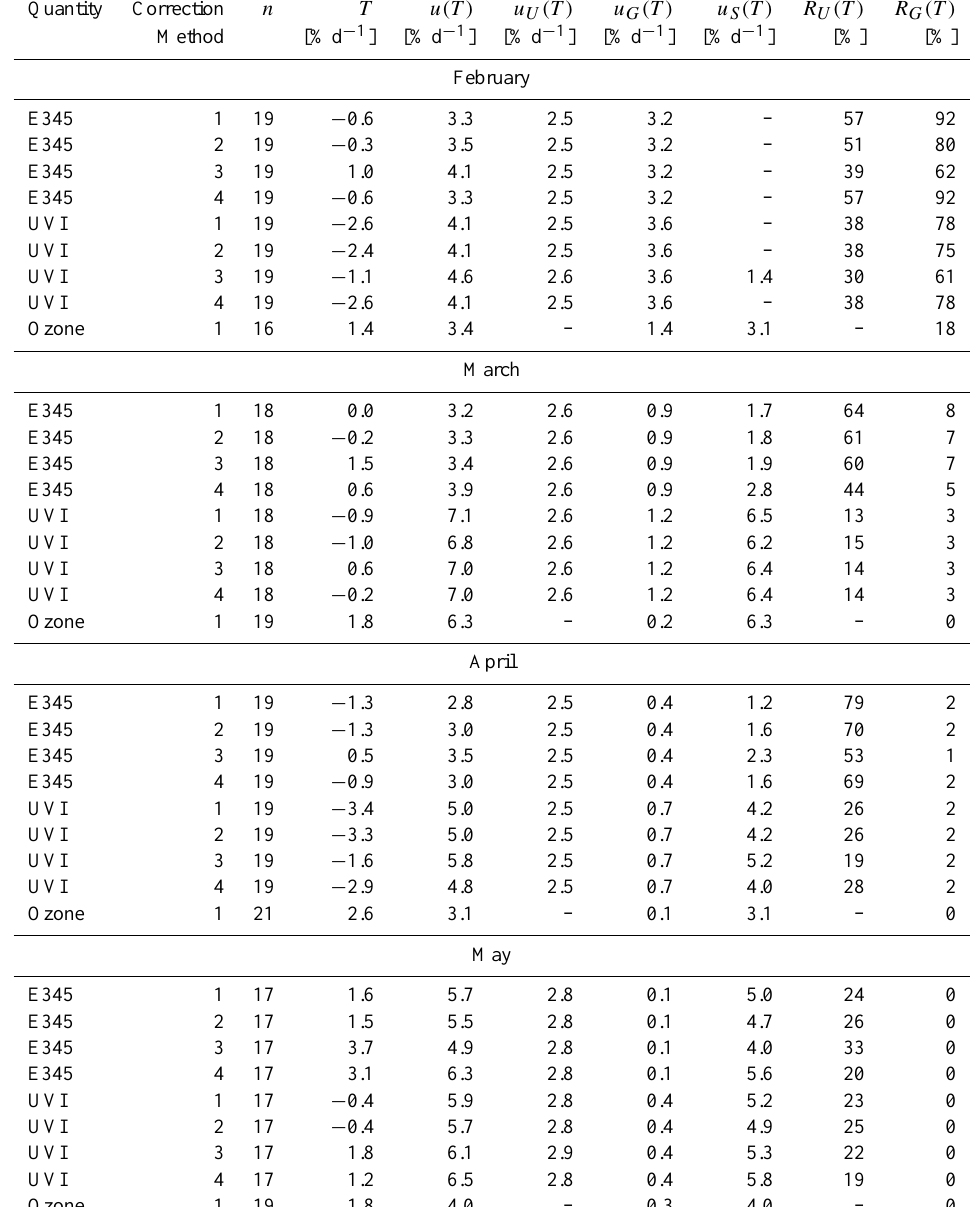
Table 2. Statistics for trend analysis. Irradiance at 345nm is abbreviated “E345”; the UV Index is abbreviated “UVI”. Trends are provided as “percental change per decade” [%d − 1 ]. Significant trends are printed bold face. n is the number of years used in the trend